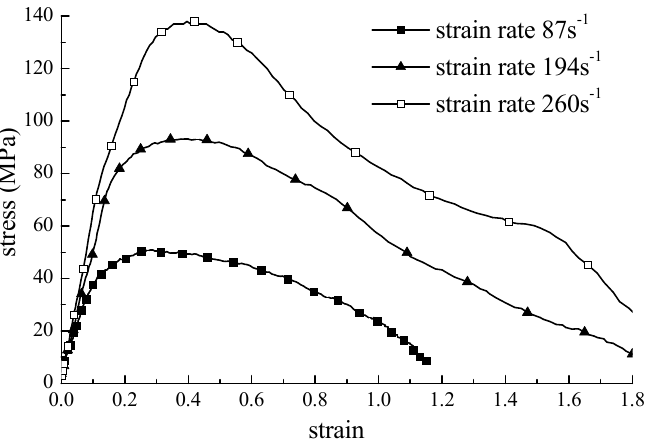
Figure 3. Stress-strain curve depending on the strain rate.